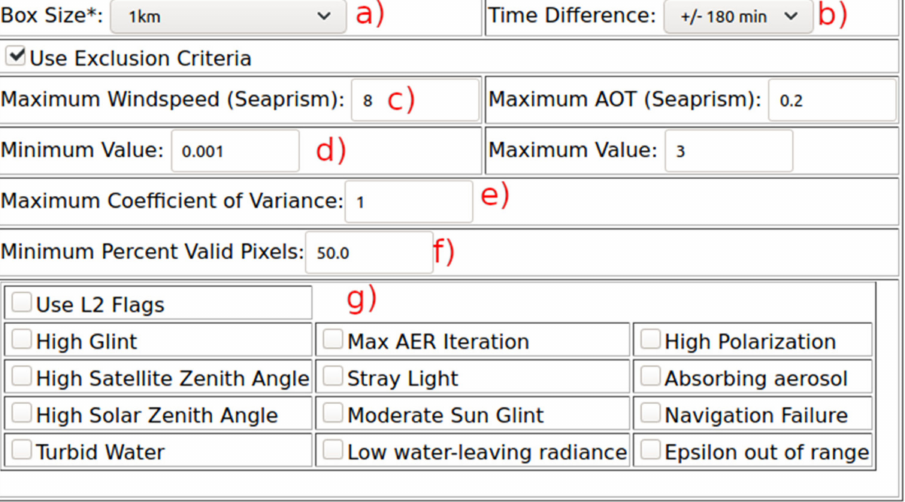
Figure 2. SAVANT exclusion criteria selection. This table represents the following possible exclusion criteria used by SAVANT: ( a ) satellite box size, ( b ) maximum time difference between in situ and satellite measurements, ( c ) maximum observed windspeed and maximum observed aerosol optical thickness, ( d ) minimum and maximum value of normalized water-leaving radiance, ( e ) maximum coefficient of variation of satellite box, ( f ) minimum percent of valid pixels in the satellite box, and ( g ) additional data quality control